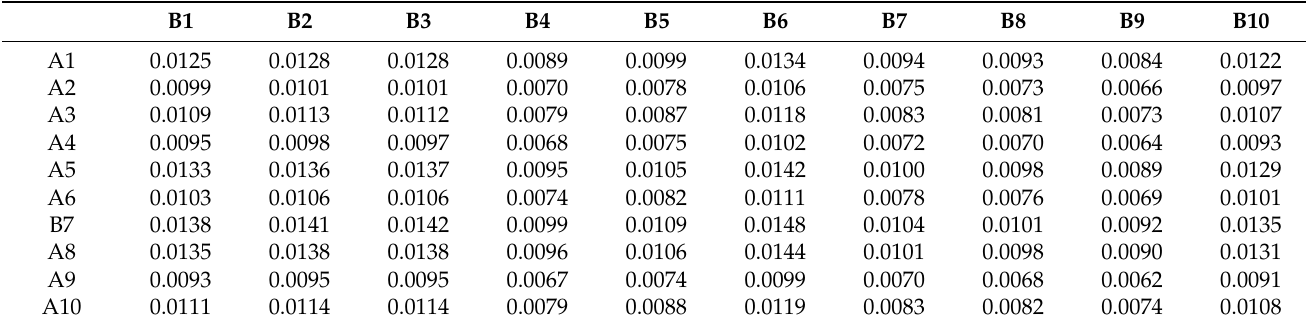
Table 12. Standardization of the initial matrix of risk-resilience association matrix.